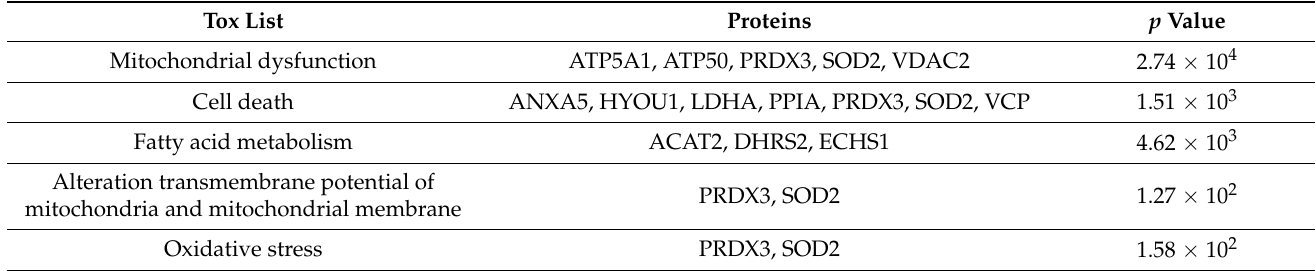
Table 1. Ingenuity Pathway Analysis of the top toxic pathways in the HepG2 cells treated with cigliti- zone.